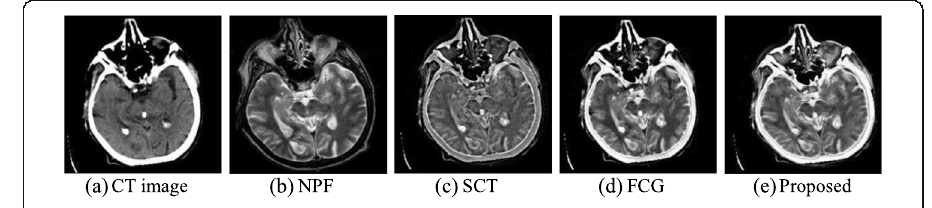
Fig. 7 CT/fusion images of multiple cerebral infarction. a CT image. b NPF. c SCT. d FCG. e Proposed